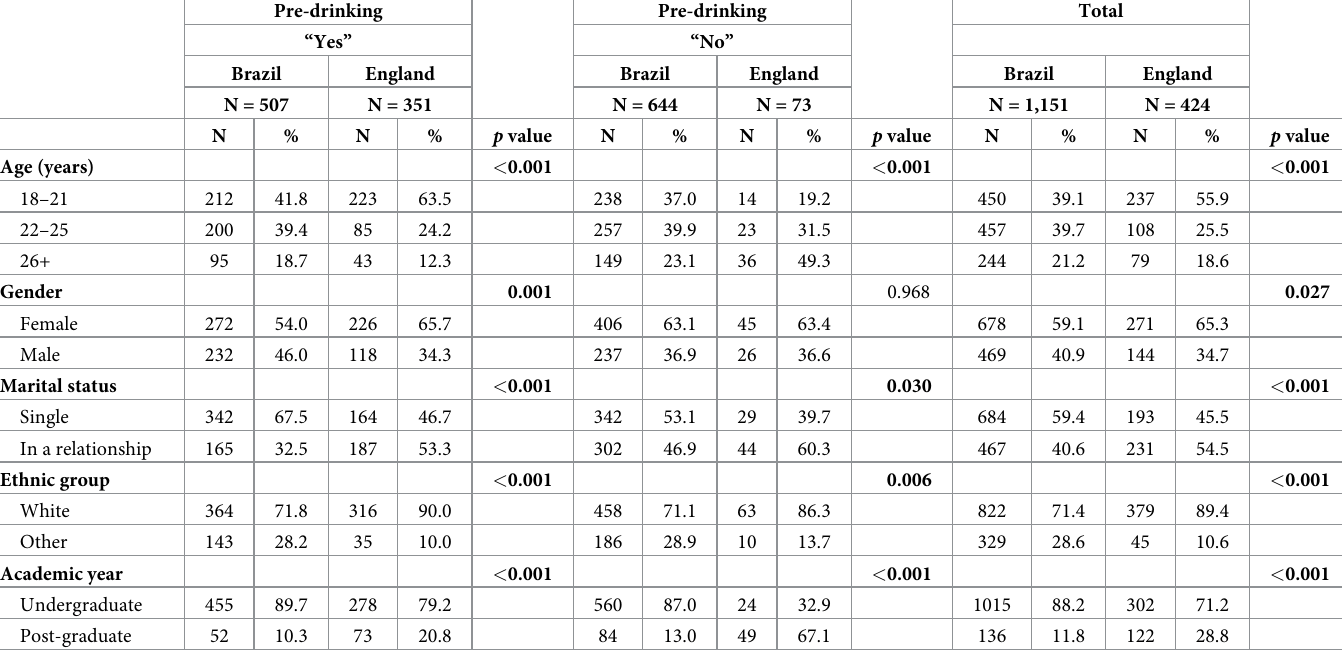
Table 2. Distribution of sociodemographic variables according to pre-drinking practice amongst Brazilian and British university students.